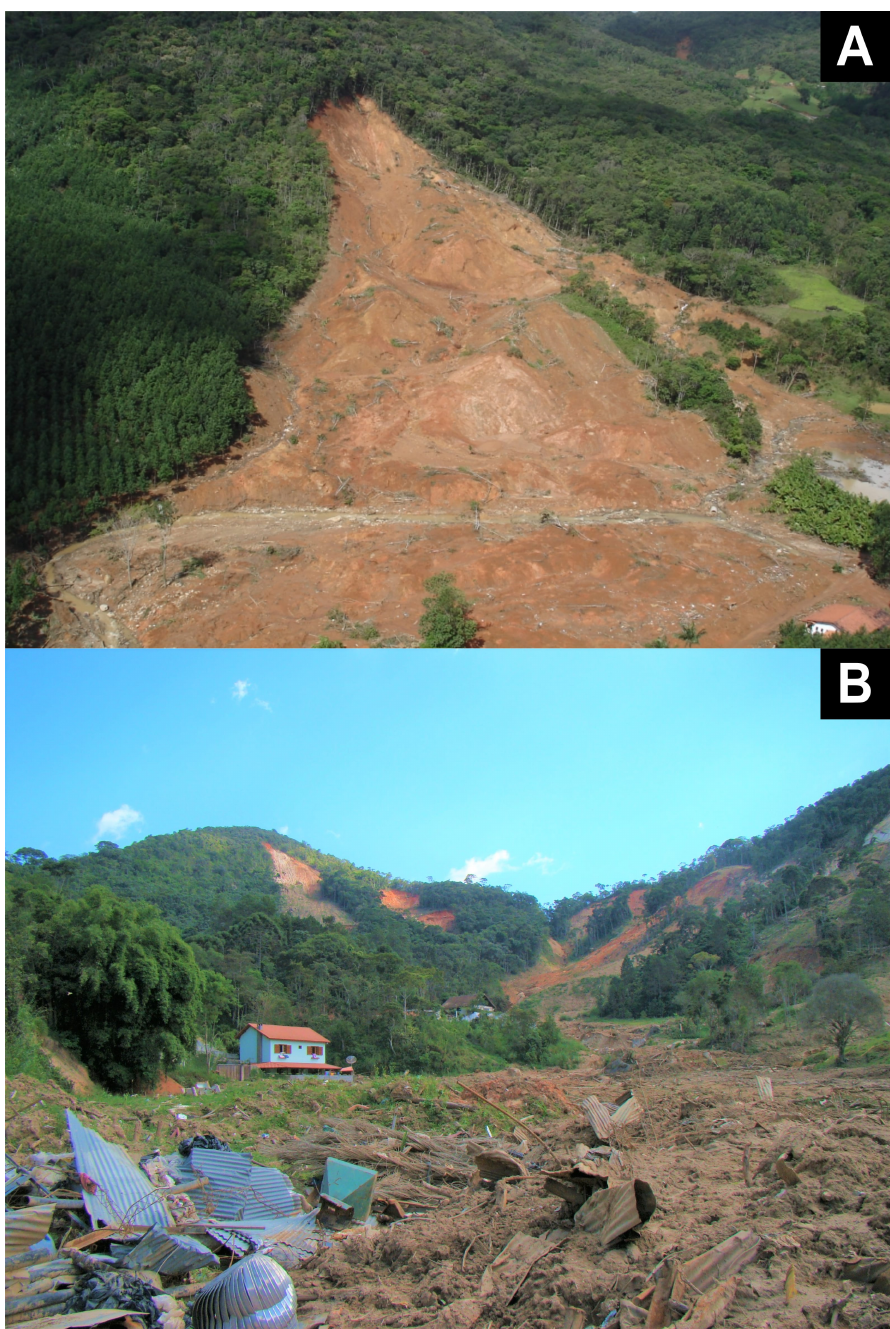
Figure 4. High-magnitude landslide events in Brazil. ( A ) Landslide in Santa Catarina, 2008 (Source: IPT); ( B ) Shallow landslides in an inhabited area in Rio de Janeiro mountain range, 2011 (Source: Marcelo F.